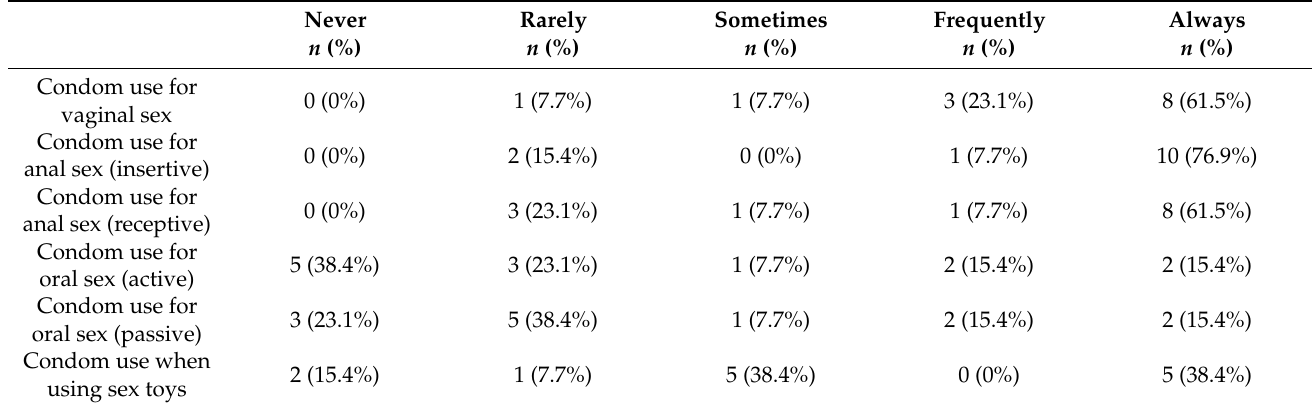
Table 3. Sexual Practices with